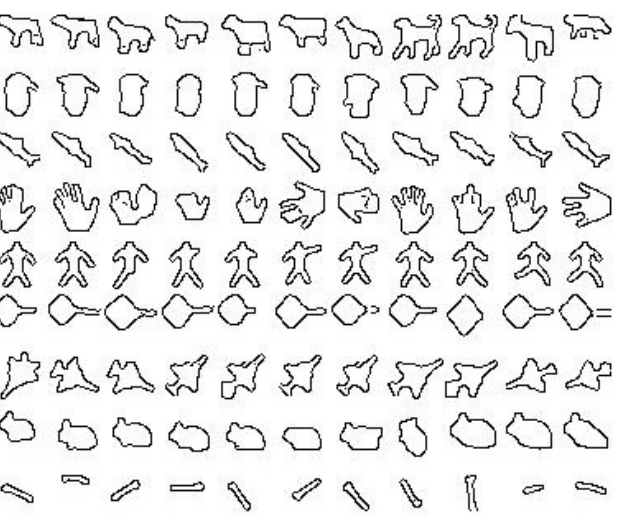
Figure 12. Example of shapes in the Kim99 dataset. One object for each one of the nine categories is shown.